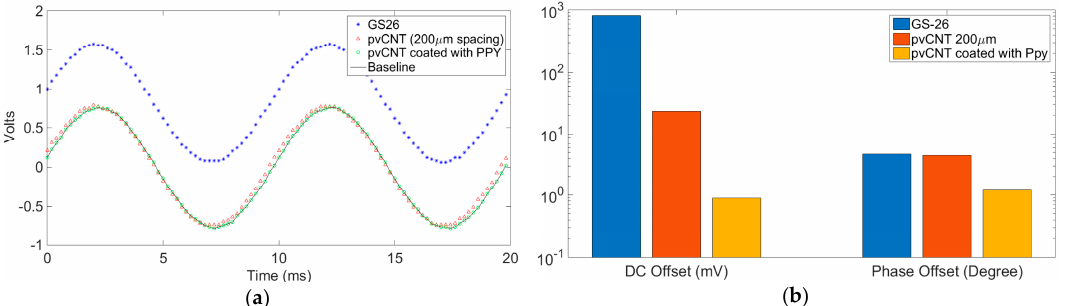
Figure 7. In vitro test results of the electrodes. ( a ) Signal capture by coated and non-coated pvCNT dry electrodes compared to the commercial gel GS-26 electrodes interfaced with Al foil. ( b ) Plots comparing DC offset voltages and phase offsets of these electrodes.